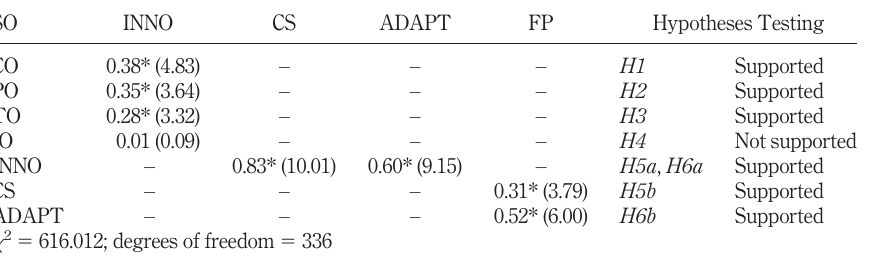
Table I. The results of